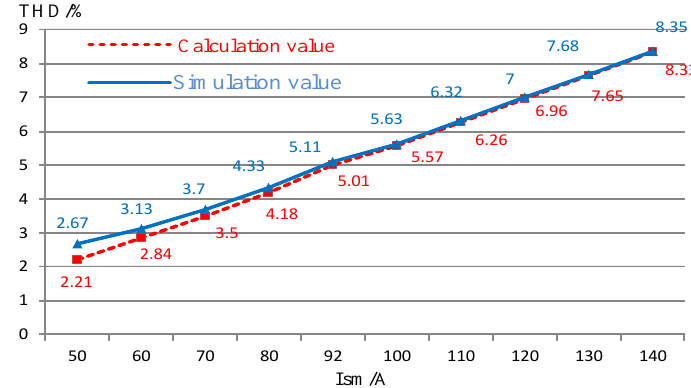
Figure 16. Theoretical and simulation THD under a unity power factor.